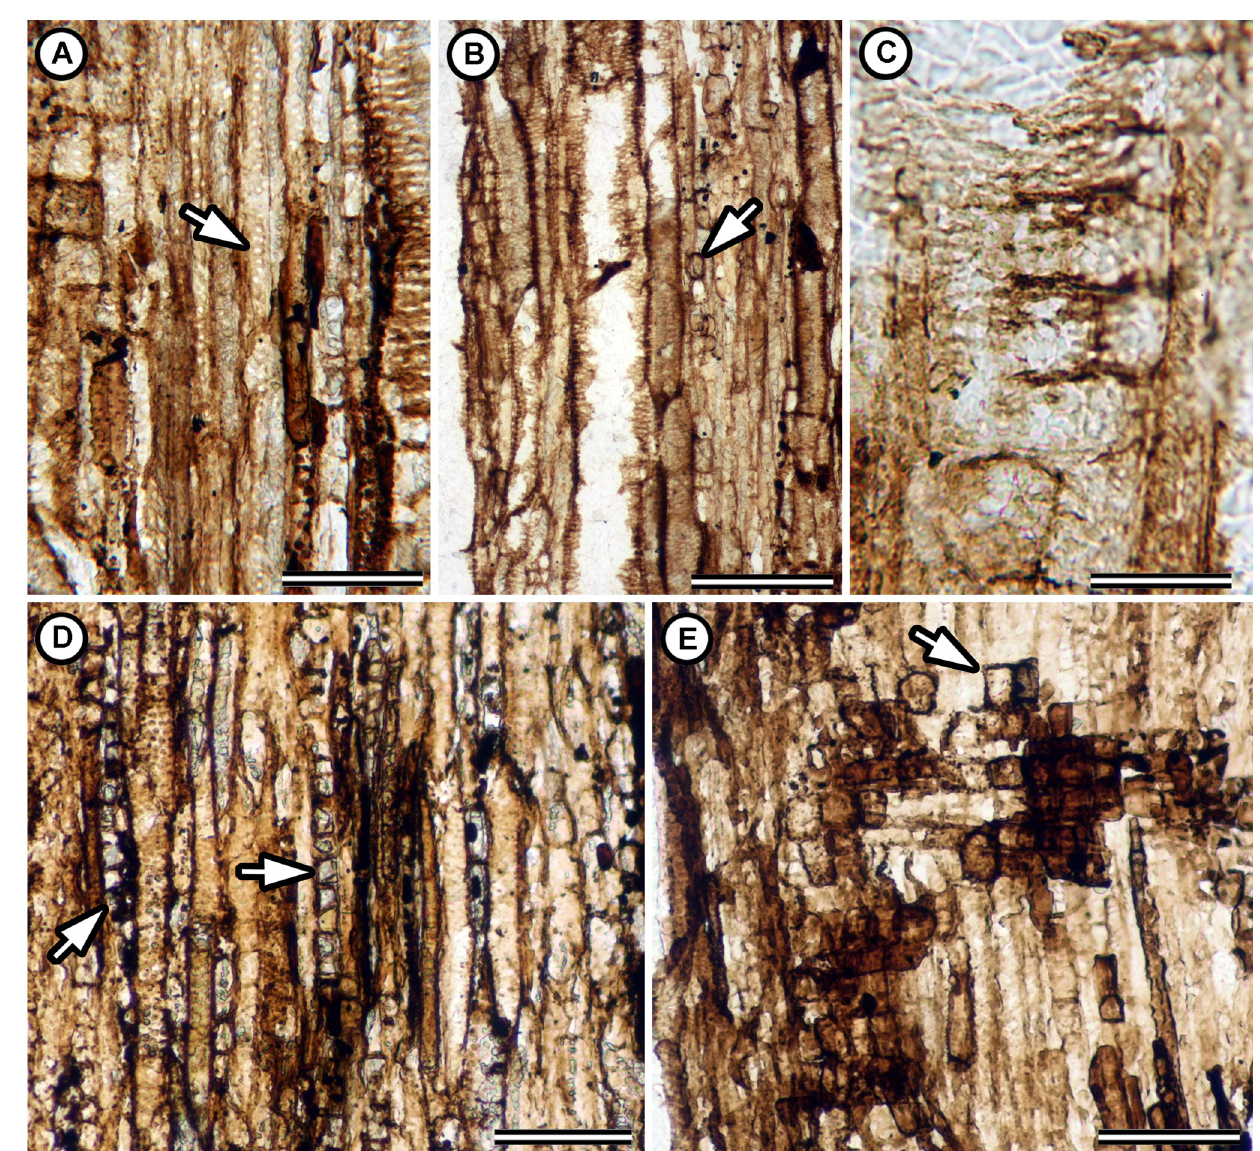
Fig 3. Wood anatomy in Ampelorhiza heteroxylon . (A) Tangential longitudinal section showing uniseriate pitting on the fiber walls. Specimen UF 19391- 63016 LS peel 5. (B) Tangential longitudinal section showing axial elements including narrow vessels and uniseriate rays (at arrow). Specimen UF 19391- 63016 LS peel 1. (C) Radial longitudinal section showing ray cells against a vessel. Note the partially preserved vessel-ray parenchyma pitting similar in size to the intervessel pitting (at arrow). Specimen UF 19391-63016 LS peel 7. (D) Tangential longitudinal section showing uniseriate and biseriate rays (left arrow) and axial elements with crystals (right arrow). Specimen UF 19391-63016 LS peel 5. (E) Radial longitudinal section showing upright (at arrow), square, and procumbent ray cells. Specimen UF 19391-63026 LS peel 2. Scale bars: A = 70 μ m; B = 150 μ m; C = 40 μ m; D, E = 100 μ